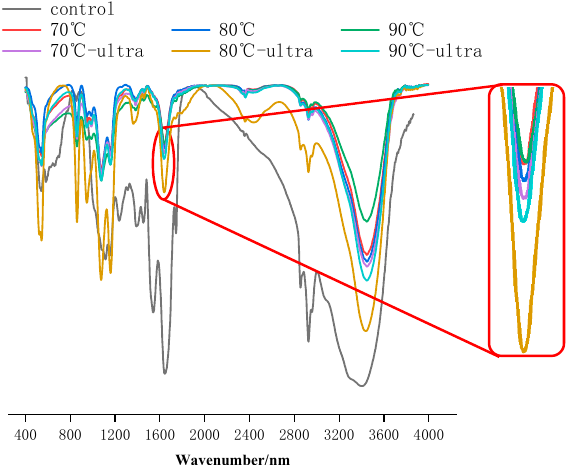
Figure 4. FTIR of different coconut globulin samples (ultra: 53 kHz, 40 w / l , 20 min; 70, 80 and 90 °C represent preheating for 20 min). Table 1. Secondary structures of different coconut globulin samples (ultra: 53 kHz, 40 w / l , 20 min; 70, 80 and 90 °C represent preheating for 20 min). Different letters indicate significant differences at p < 0.05.